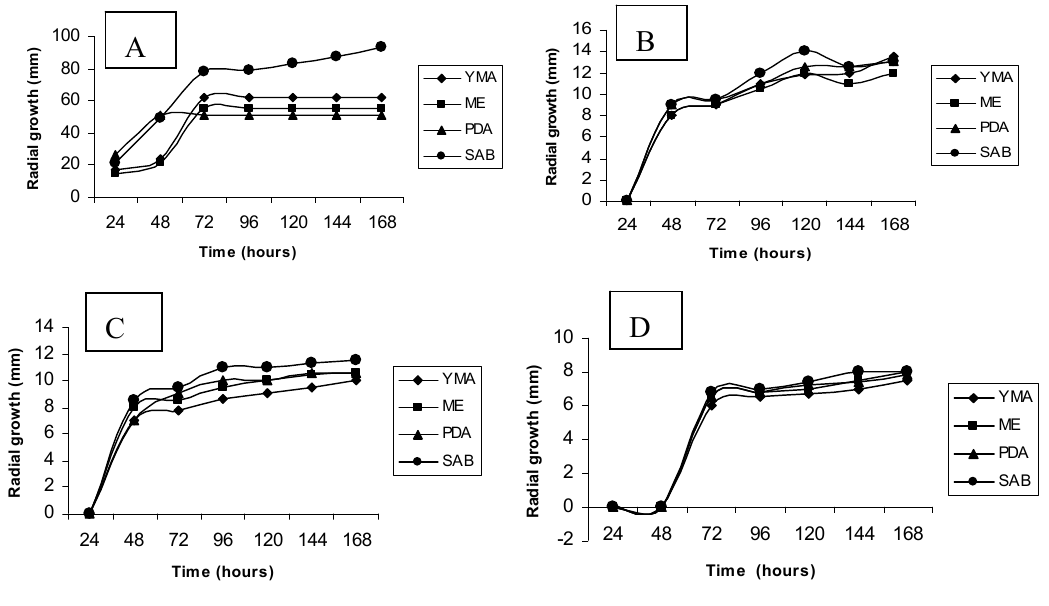
Figure 1. Radial growth of Trichoderma harzianum in different culture media, aiming to select a standard medium for the physiological and biochemical investigations. A- Control ; B- Treated with cadmium 1 mM; C- Treated with cadmium 2mM; D- Treated with cadmium 3mM. YMA (Yeast Malt Agar); ME (Malt Extract); PDA (Potato Dextrose Agar) and SAB (Sabouraud Dextrose